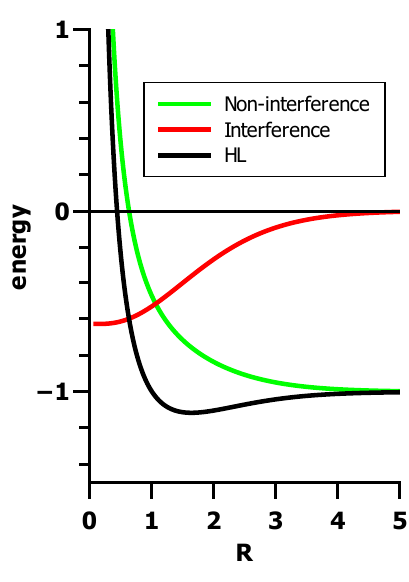
Figure 22. Partitioning of the Heitler–London energy into classical contributions and contributions caused by